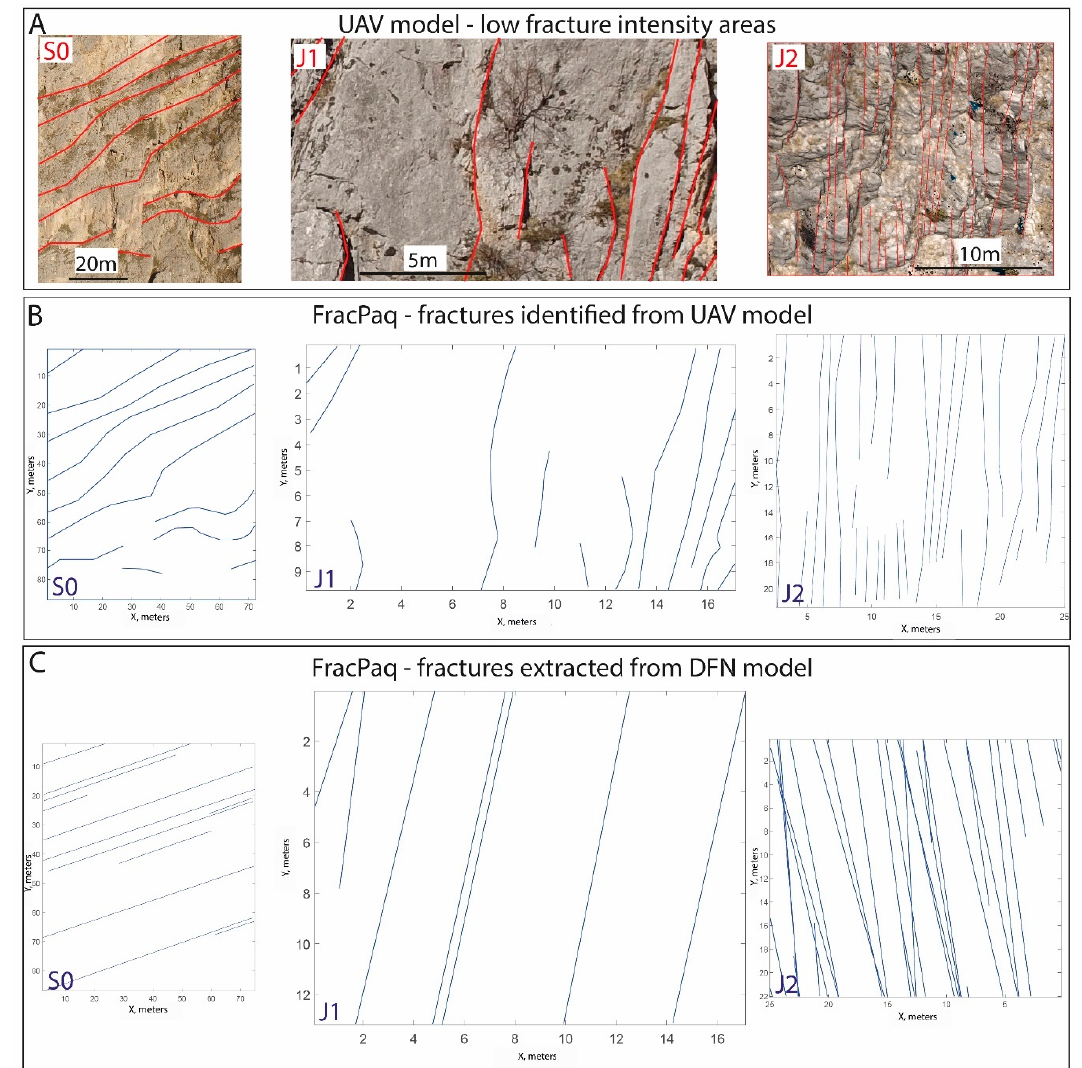
Figure 9. ( A ) Example of sampling windows from low fracture intensity areas. ( B ) Fractures identified in sampling windows and used for the calculation of P 21 . ( C ) Sections extracted from DFN 2 after model validation.